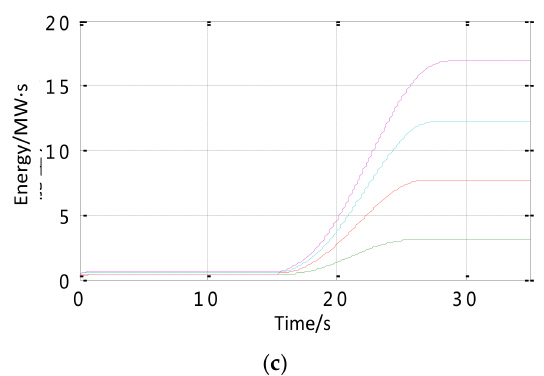
Figure 6. The inertial response and system output of HESS capacity changes. ( a ) The frequency’s response curve at the load sudden increase; ( b ) The frequency’s response curve at the load sudden decrease; and ( c ) Energy’s response